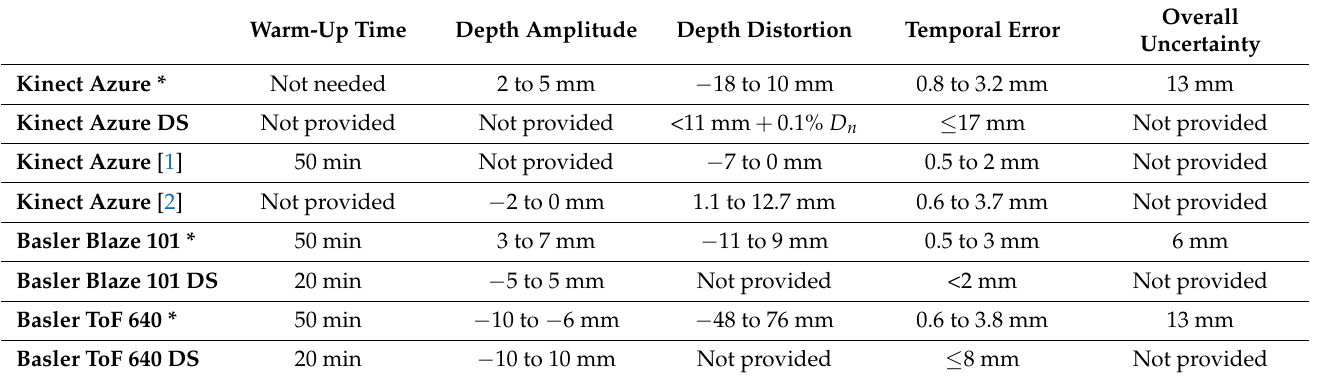
Table 3. Summary of the error sources influence resulting from our experiments in comparison with relevant references and cameras’ datasheets. Asterisks refer to data obtained by our procedure. DS refers to data found in the device’s